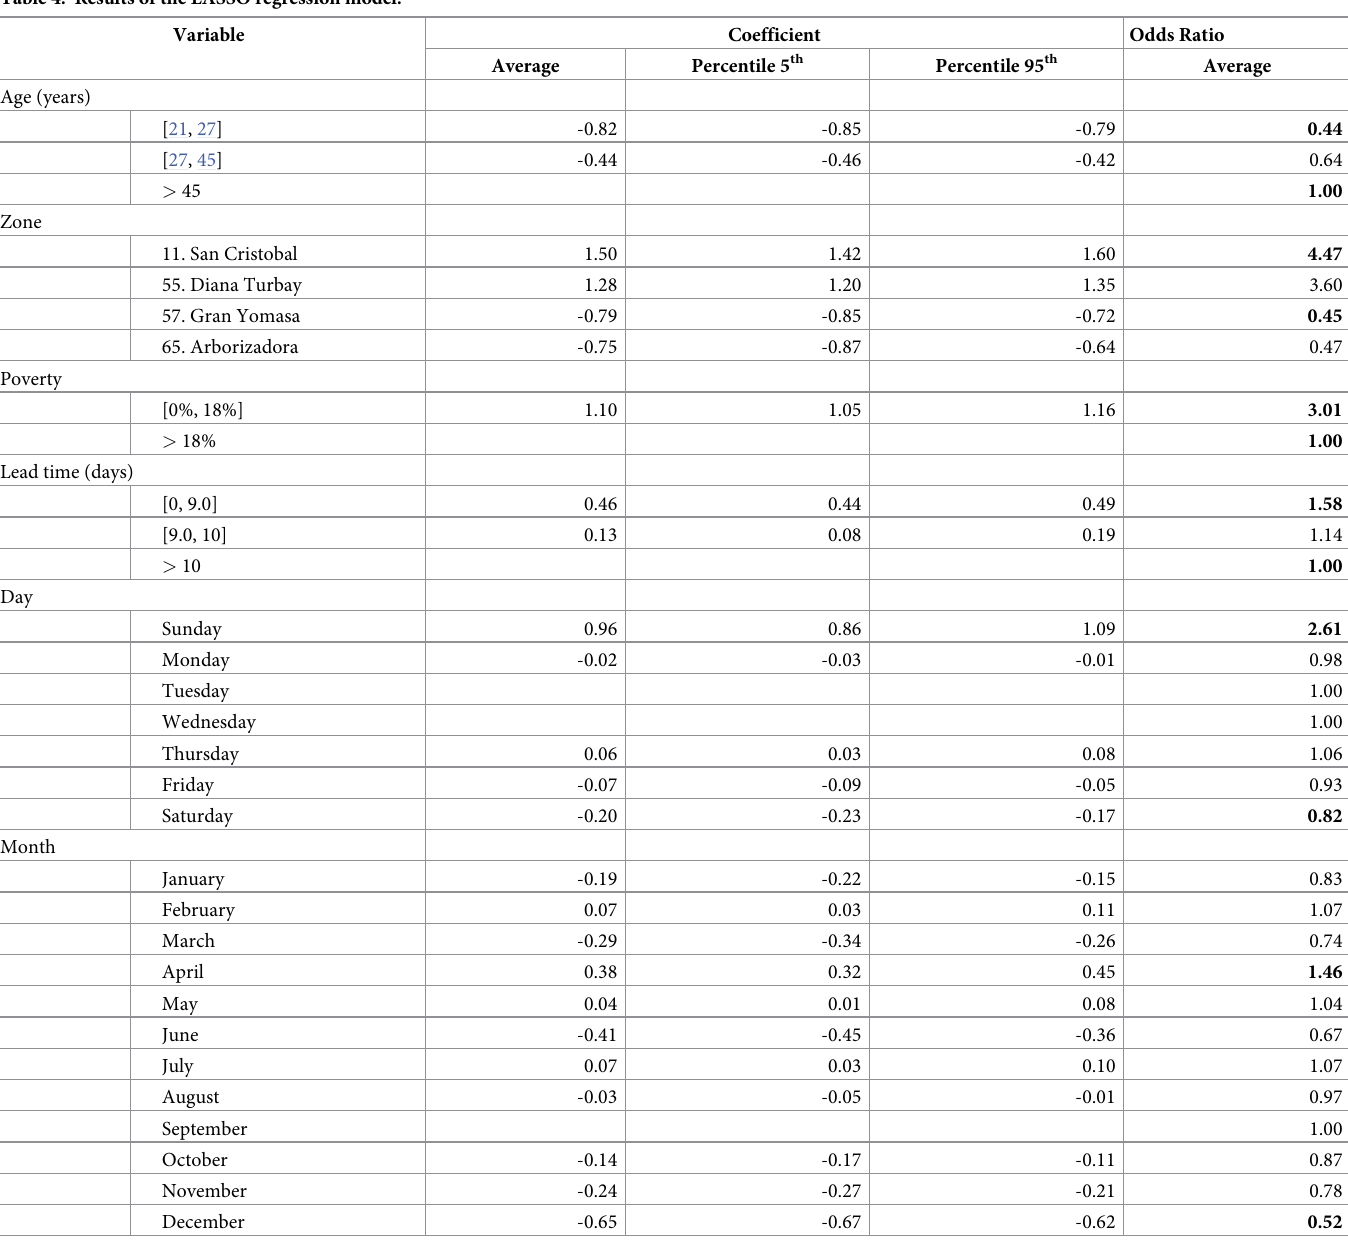
Table 4. Results of the LASSO regression